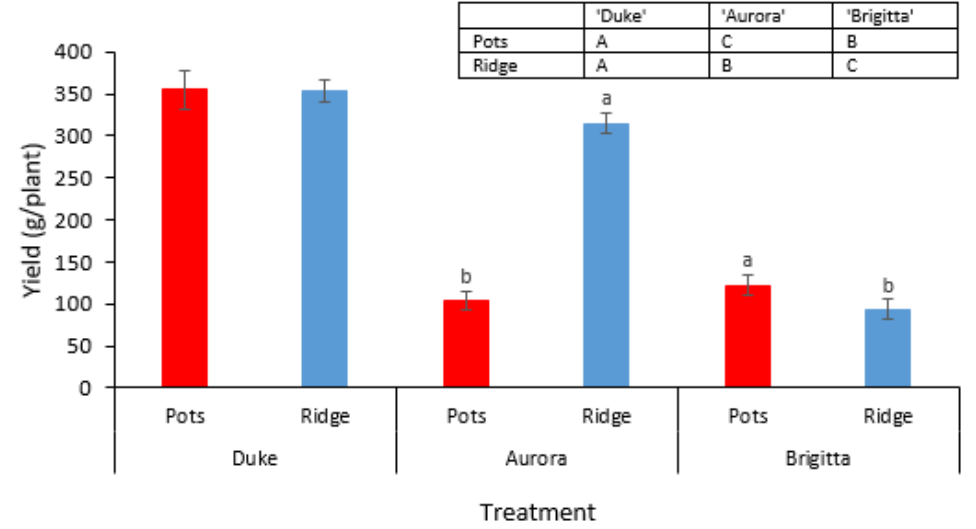
Figure 4. Fruit yield for the ‘Duke’, ‘Aurora’, and ‘Brigitta’ blueberry cultivars grown in pots and along the ridge. Different lowercase letters indicate statistically significant differences between planting methods within cultivars ( t ‐ tests, α < 0.05), and different uppercase letters (inset) between cultivars within planting methods (LSD tests, α < 0.05).